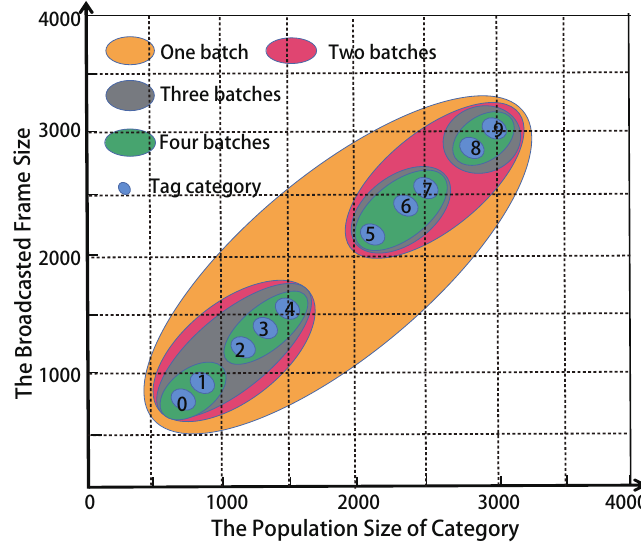
Figure 3. Category